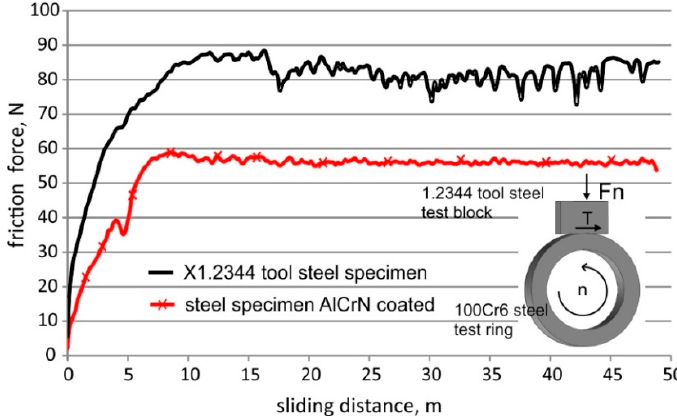
Figure 3. Diagram of changes in friction force vs. friction distance (T-05 tester).